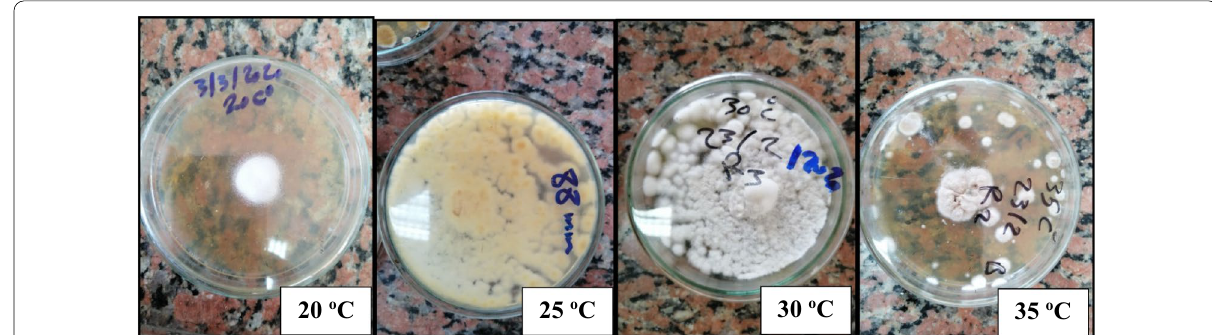
Fig. 1 Effect of temperatures on the development of isolated fungus ( Beuvaria bassiana